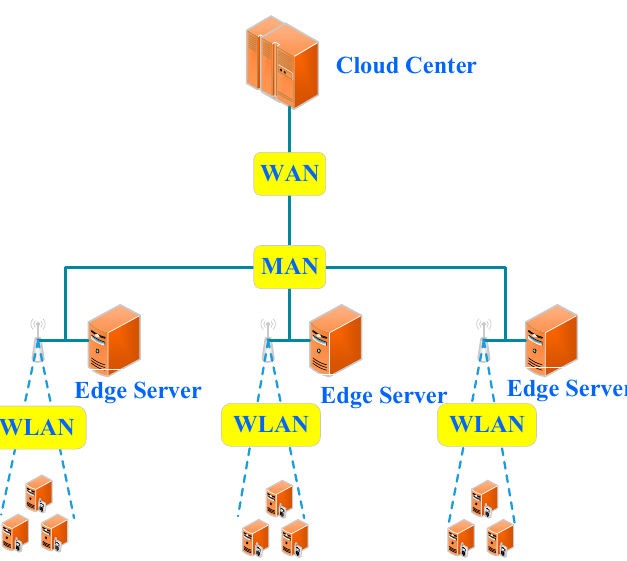
Figure 4. Edge-cloud computing.